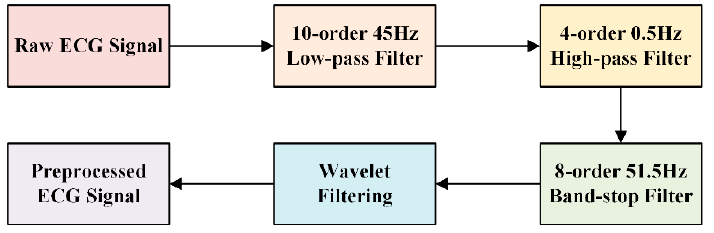
Figure 8. Block diagram of ECG preprocessing.